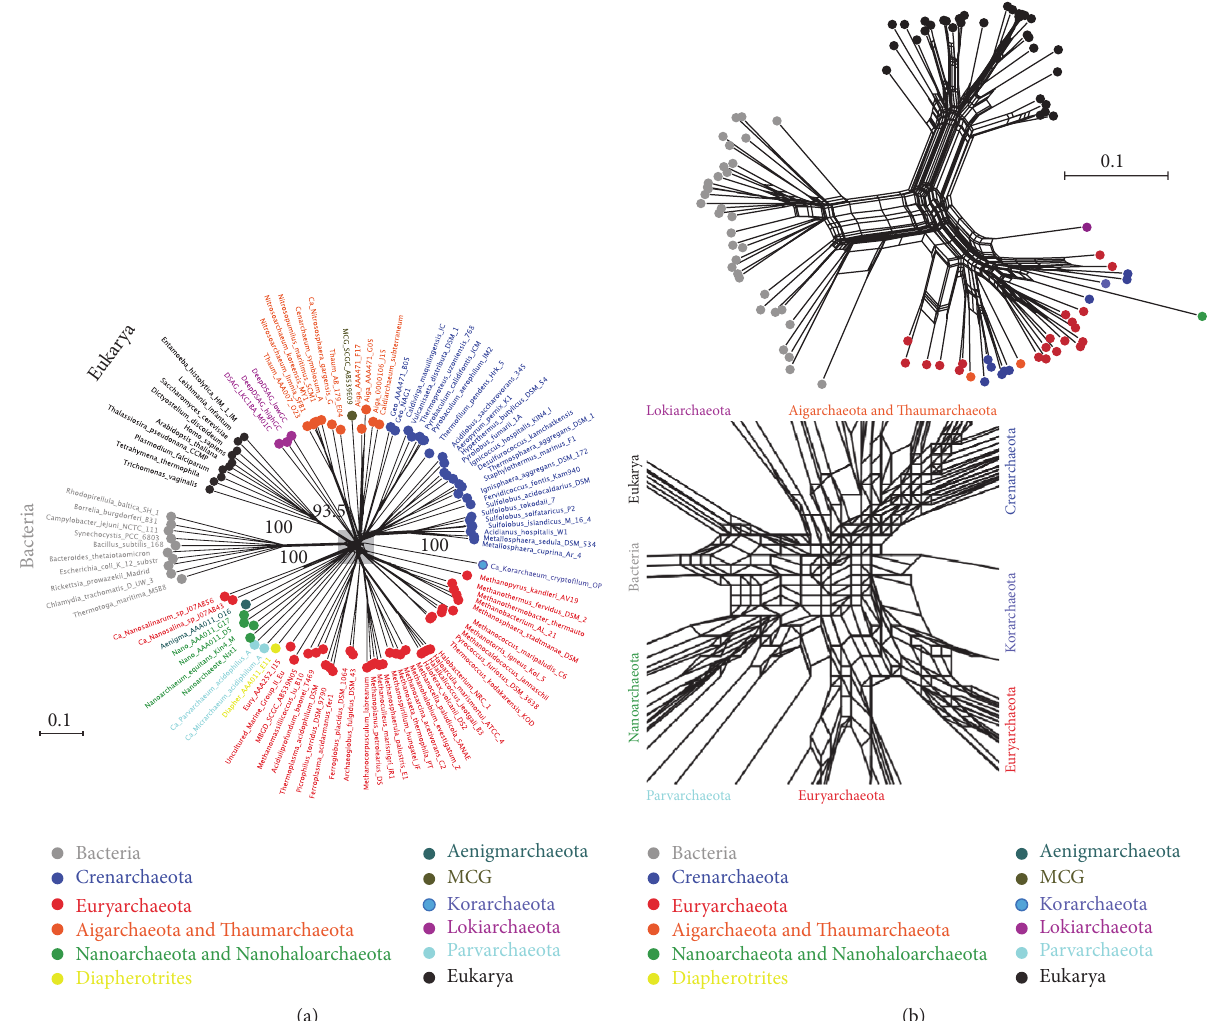
Figure 3: Distance networks do not support AAS. (a) The concatenated alignment of Spang et al. (2015) was provided by Lionel Guy and Thijs Ettema [1]. This alignment concatenated 36 genes (arCOGs) in 104 taxa (84-10-10 dataset) and was already trimmed by authors to remove sites containing > 50% gaps. A splits-tree distance-based network (character sites = 10,547, LS fit = 99.97; 𝛿 -score = 0.25) reconstructed from the 84-10-10 dataset does not support AAS [1]. Eukaryotic proteomes are in close proximity to Lokiarchaeota but form a monophyletic group of their own. Numbers on branches indicate BS support values for deep split events. The inset shows reticulations at the base of the tree. MCG: miscellaneous crenarchaeotal group. (b) An unrooted splits-tree distance-based network (character sites = 493, LS fit = 99.61; 𝛿 -score = 0.24) reconstructed from 34-34-34 dataset sampled from Archaea (including Lokiarchaeum ), Bacteria, and Eukarya and 493 characters corresponding to presence/absence of FSF domains in the universal ABE (459) and AE (34) groups of Figure 1. For this reconstruction, we onlyconsideredorganismsexhibiting“free-living”lifestylessinceparasiticandobligateparasiticorganismstendtohavereducedgenomesthat are distorted by their holobiont relationship biasing the data matrix. The only “non-free-living” exception was Nanoarchaeota that was added to ensure consistency with the 84-10-10 dataset and to maximize the coverage of archaeal phyla [1]. Both unrooted networks reconstructed by SplitsTree (ver. 4.13.1)